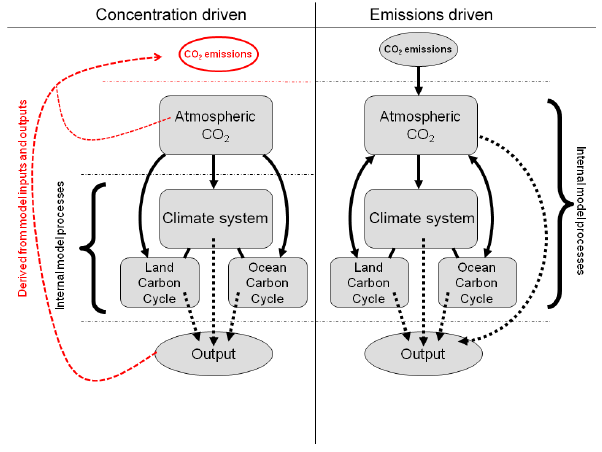
Figure 2. Schematic representation of carbon cycle numerical ex- perimental design. Concentration-driven (left) and emissions-driven (right) simulation experiments make use of the same Earth system models (ESMs), but configured differently. Concentration-driven simulations prescribe atmospheric CO 2 as a pre-defined input to the climate and carbon cycle model components. Compatible emis- sions can be calculated from the output of the concentration-driven simulations. Emissions-driven simulations prescribe CO 2 emissions as the input, and atmospheric CO 2 is an internally calculated state variable within the ESM. Adapted from Ciais et al. (2013). Solid arrows depict internal data flow within the model, dashed arrows depict data output from the model.